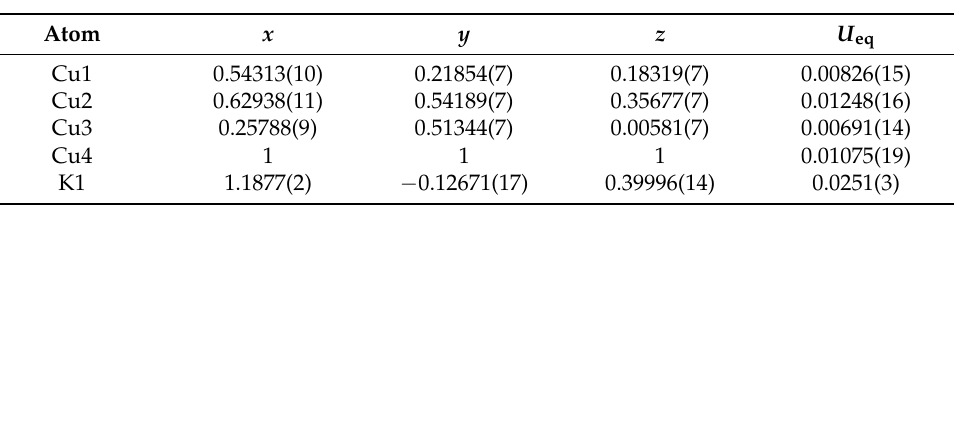
Table A1. Fractional atomic coordinates and isotropic displacement parameters (Å 2 ) for 1